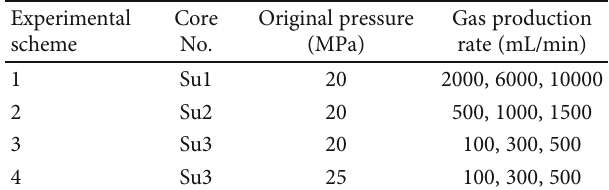
Table 2: Di ff erent experiments for the reservoir utilization